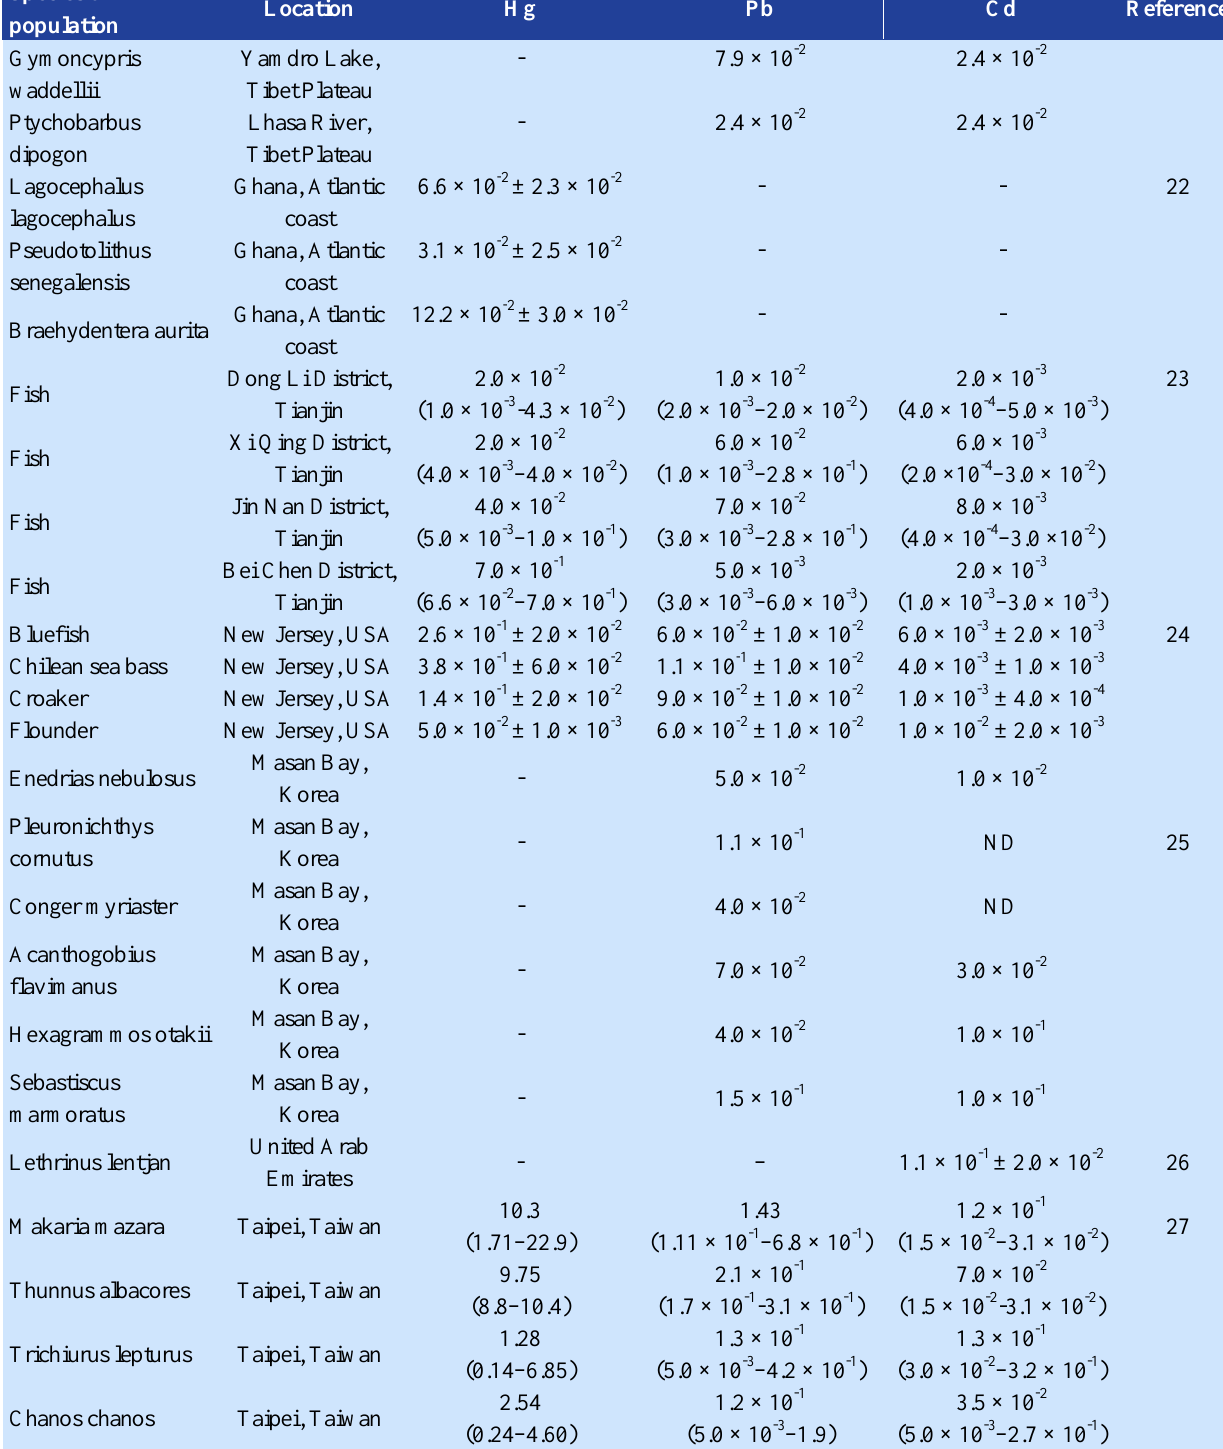
Table 4. Heavy metal concentrations (µg.g-1 dry weight) in fish in other water areas (Continue) Species